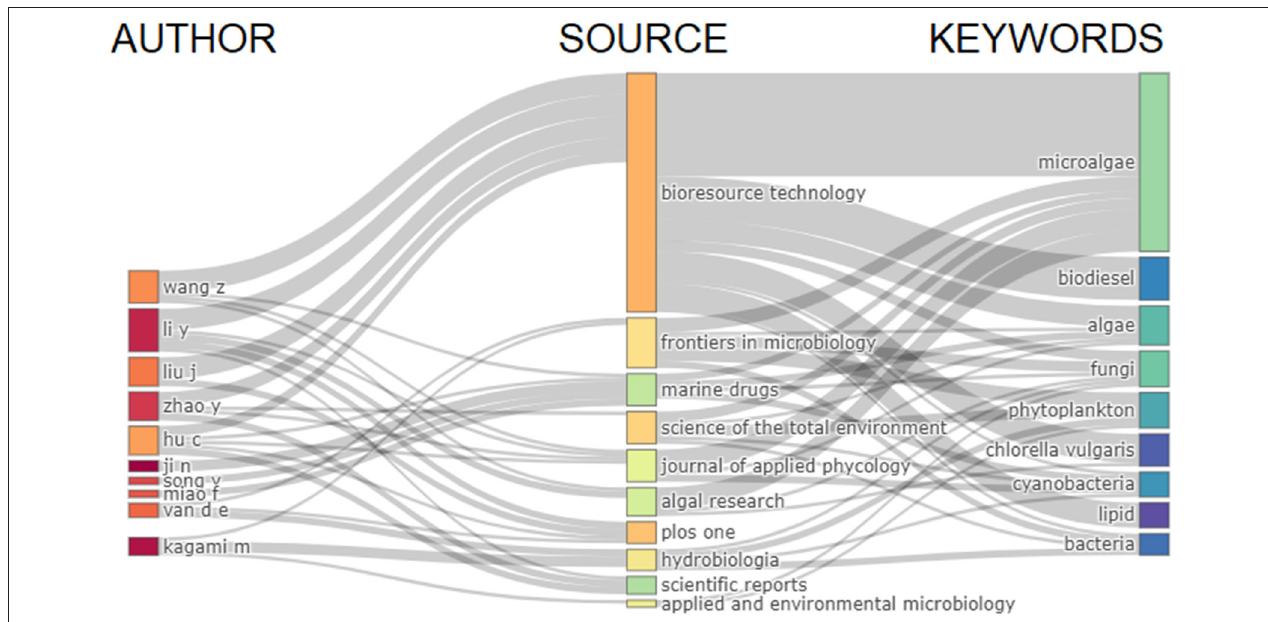
FIGURE 7 | The connection between authors, journals, and